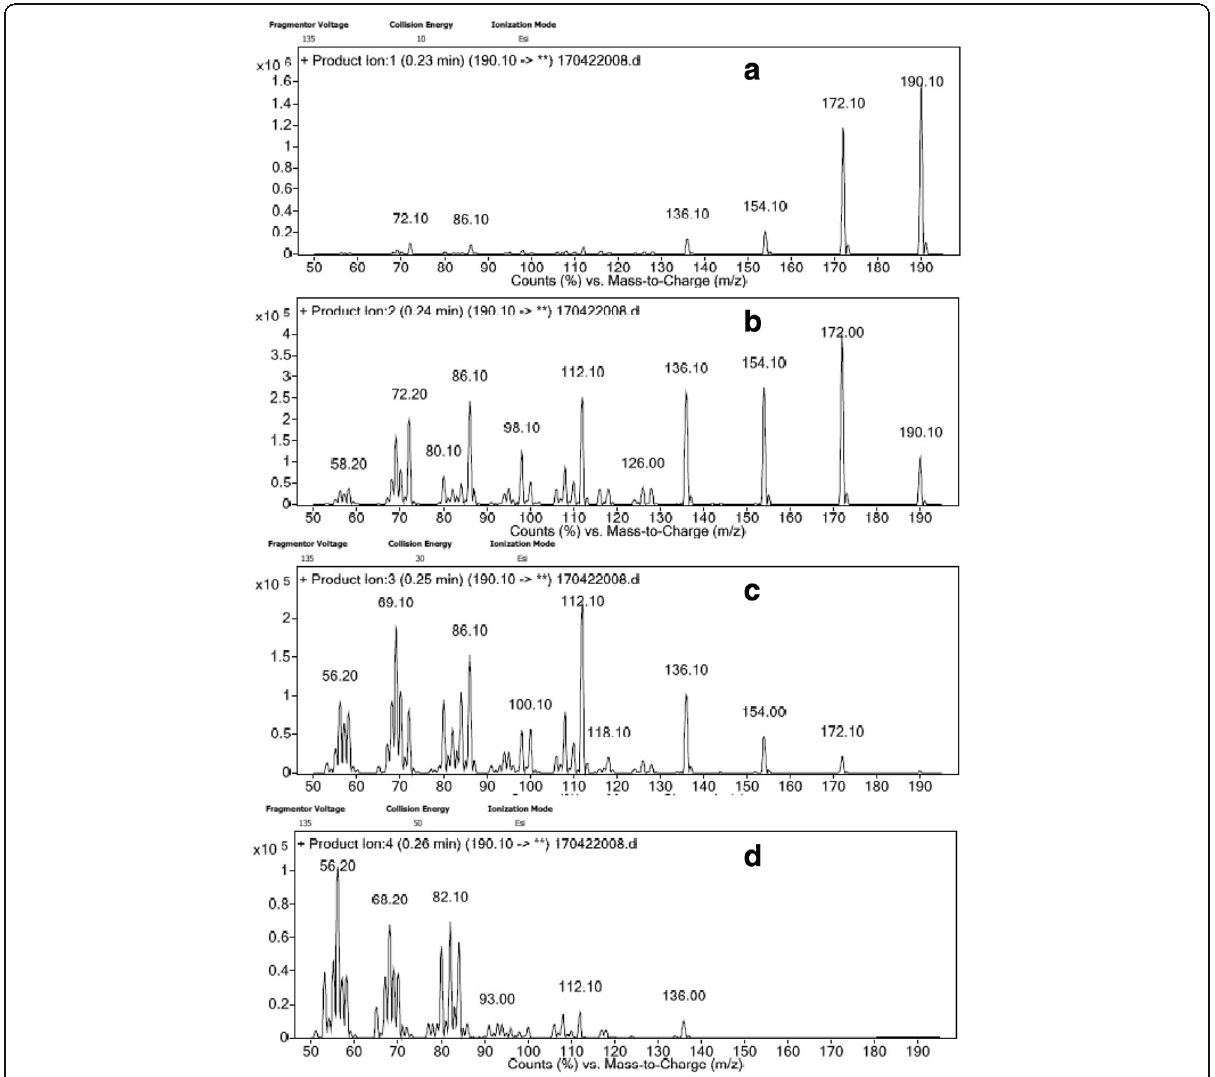
Fig. 9 MS/MS of castanospermin at a 10 eV collision energy, b 20 eV collision energy, c 30 eV collision energy, and d 50 eV collision